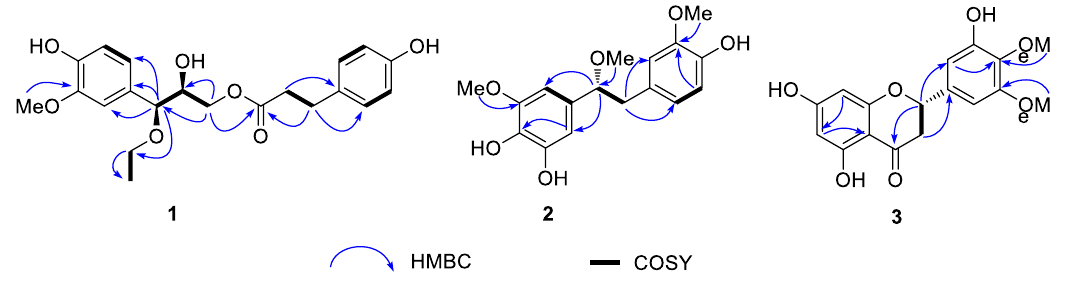
Fig. 2 The key HMBC and COSY correlations of compounds 1 –